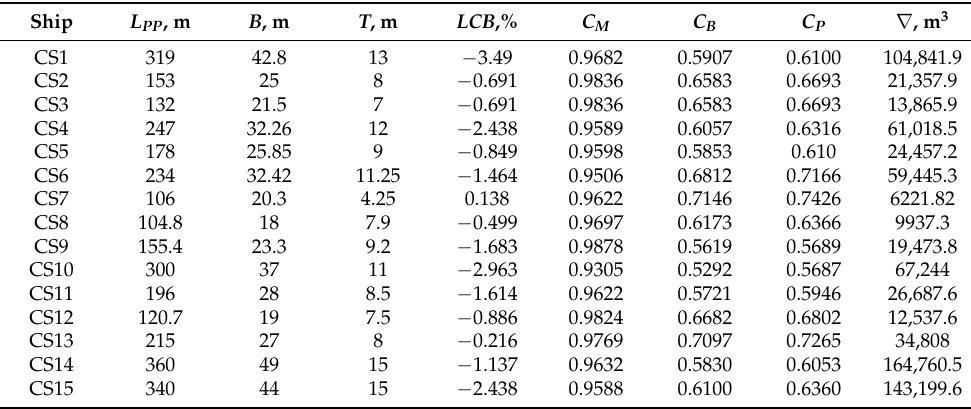
Table 2. The original hull forms of container